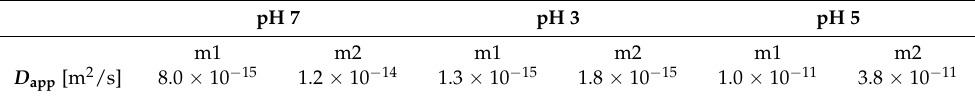
Table 2. Values for the apparent diffusion coefficient, D app , used in the model